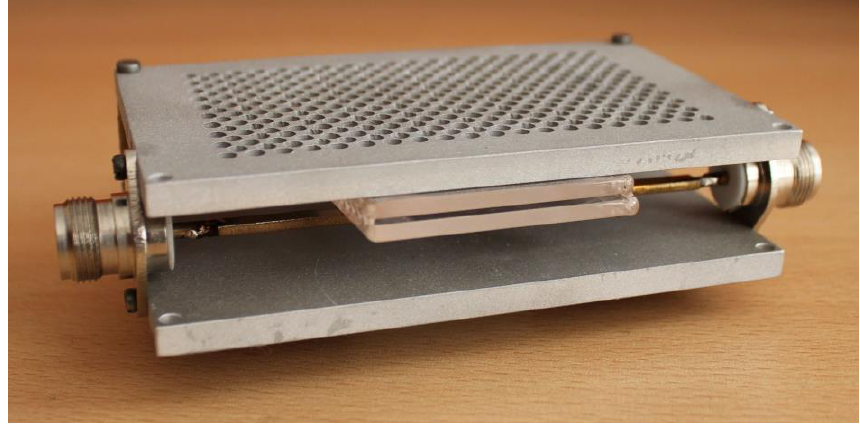
Figure 2. Photo of the stripline-based MPSS.